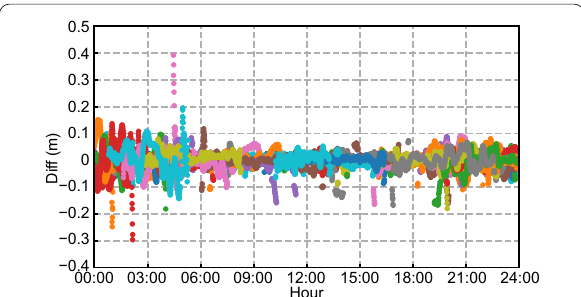
Fig. 5 The slant single-differenced-between-satellite ionospheric delay interpolation error for user site MALA in Spain, 03 August 2021 (DOY 215). Different colors represent different